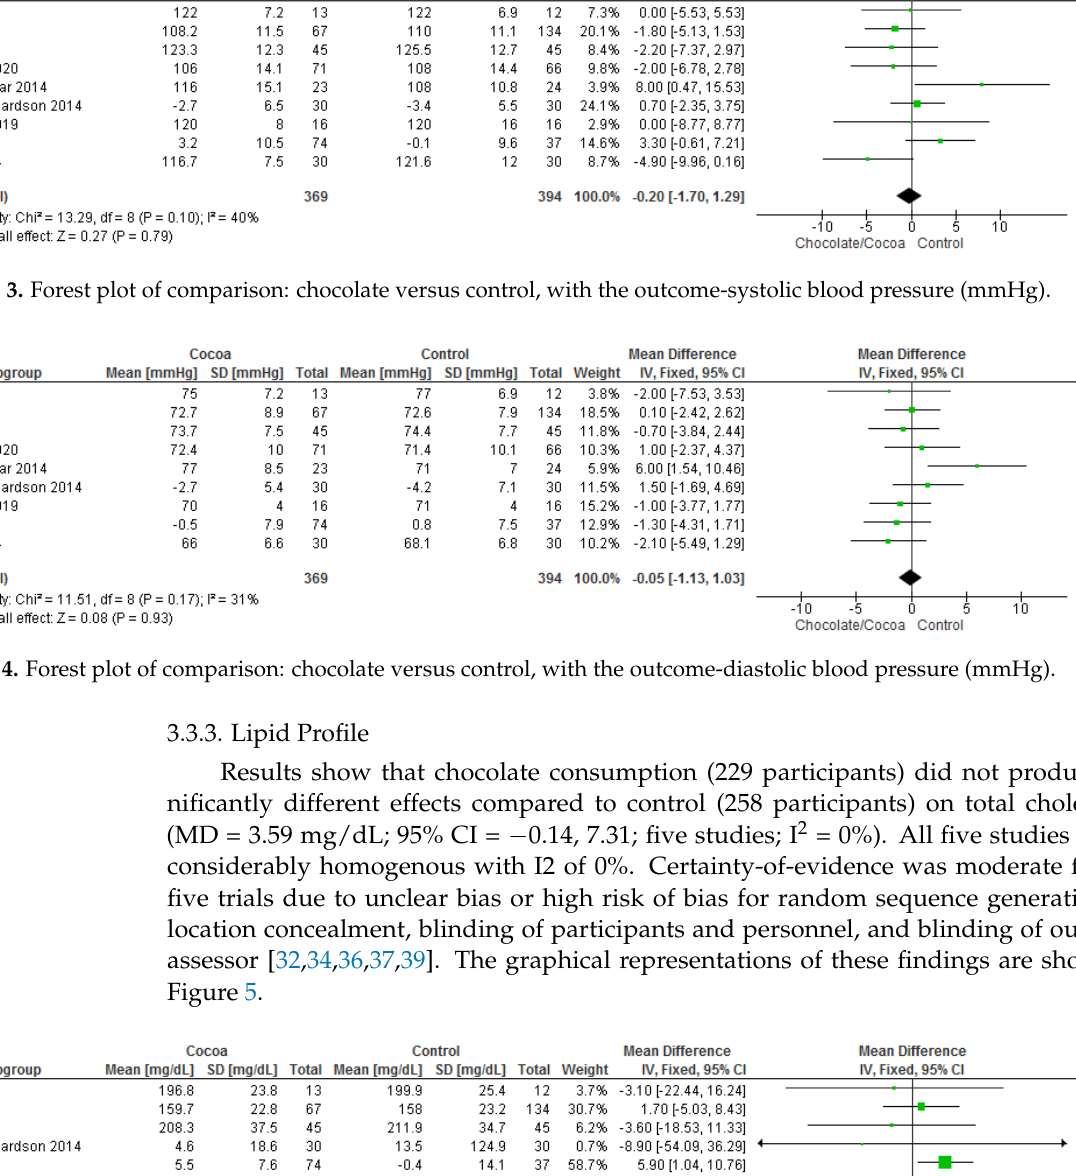
Figure 6. Forest plot of comparison: chocolate versus control, with the outcome - triglyceride (mg/dL).